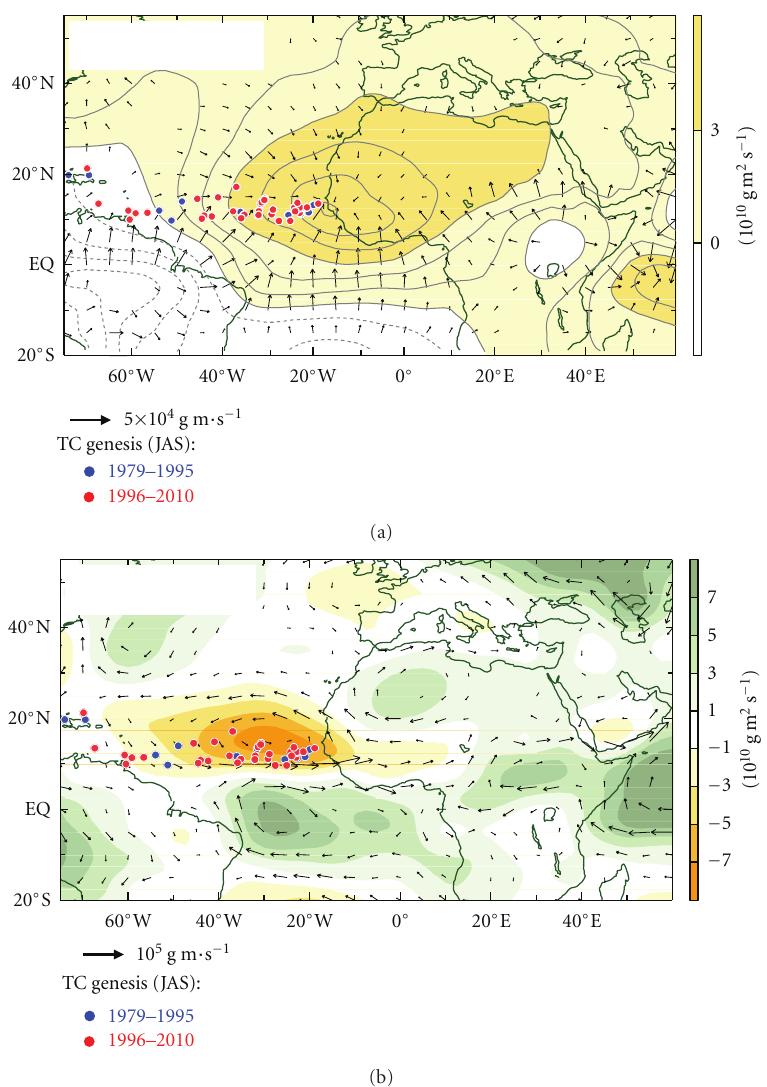
Figure 10: Horizontal maps of linear trends of (a) the potential function (VPQ; contours + shadings) and (b) the stream function (STQ; shadings) of the column-integrated water vapor flux Q = the water vapor flux (vectors). Tropical cyclogeneses during the 1979–1995 and 1996–2010 periods are overlaid as blue dots and red dots,